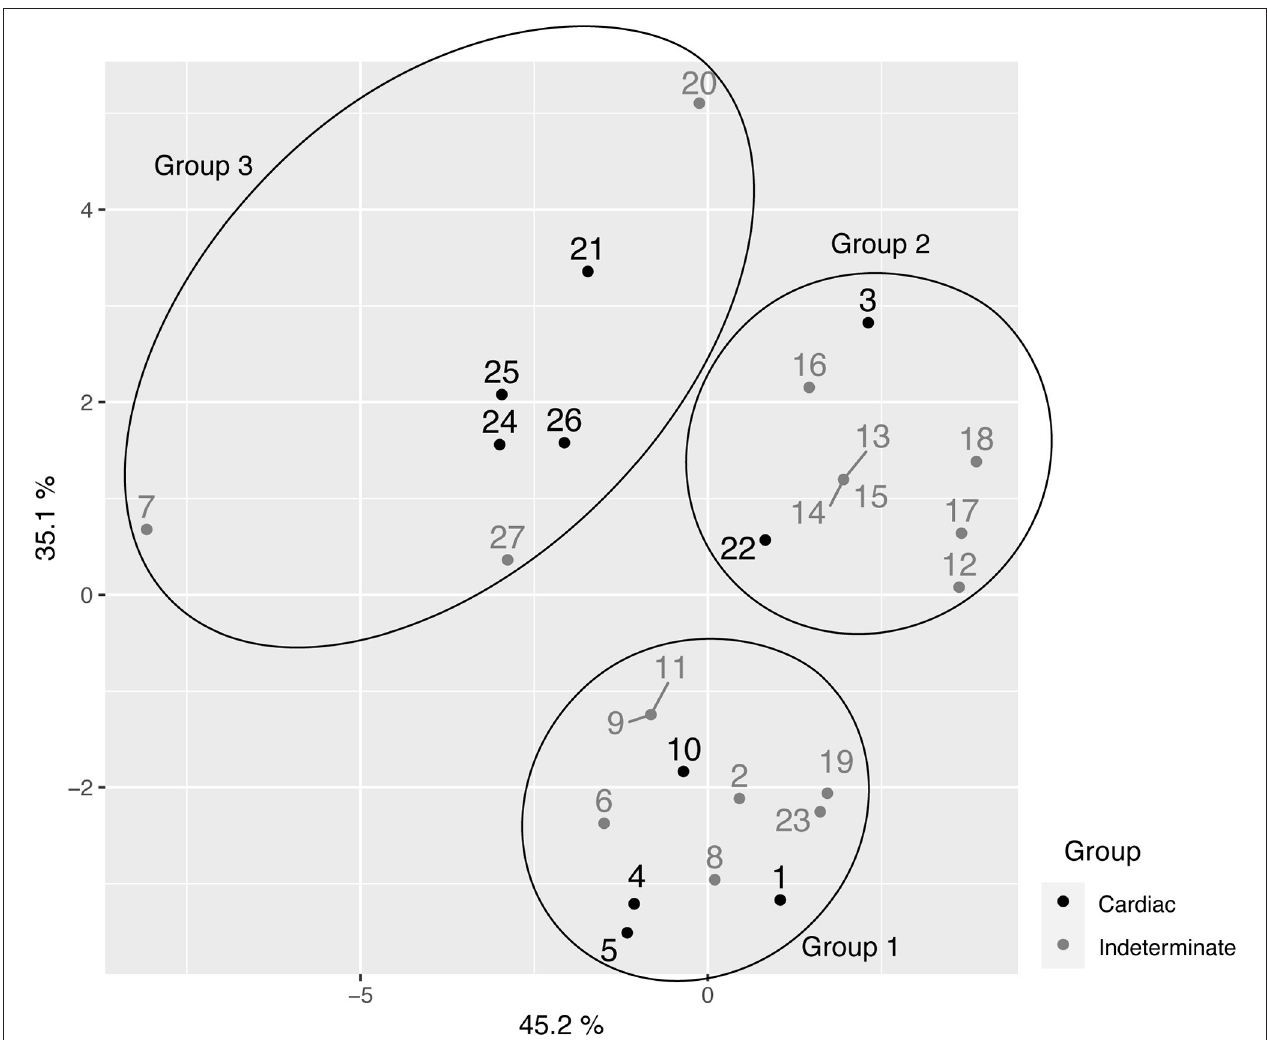
FIGURE 4 | Principal coordinated analysis (PCoA) for the 27 samples of T. cruzi belonging to the TcV discreet typing unit